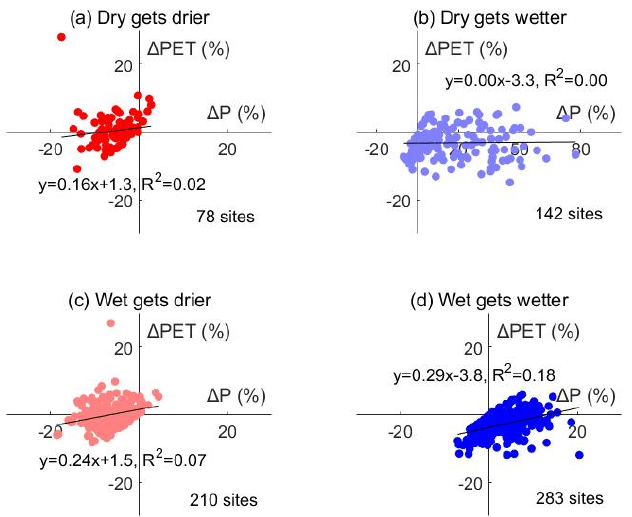
Figure 5. The “dry gets drier, wet gets wetter” pattern and changes in precipitation ( ∆ P) and potential evapotranspiration ( ∆ PET) at the 713 climate sites from 1961–1988 to 1989–2016. Each dot represents the results of a climate station. The climate sites were categorized into “dry” and “wet” when the aridity index (P / PET) in 1961–1988 was greater and less than 0.65, respectively.